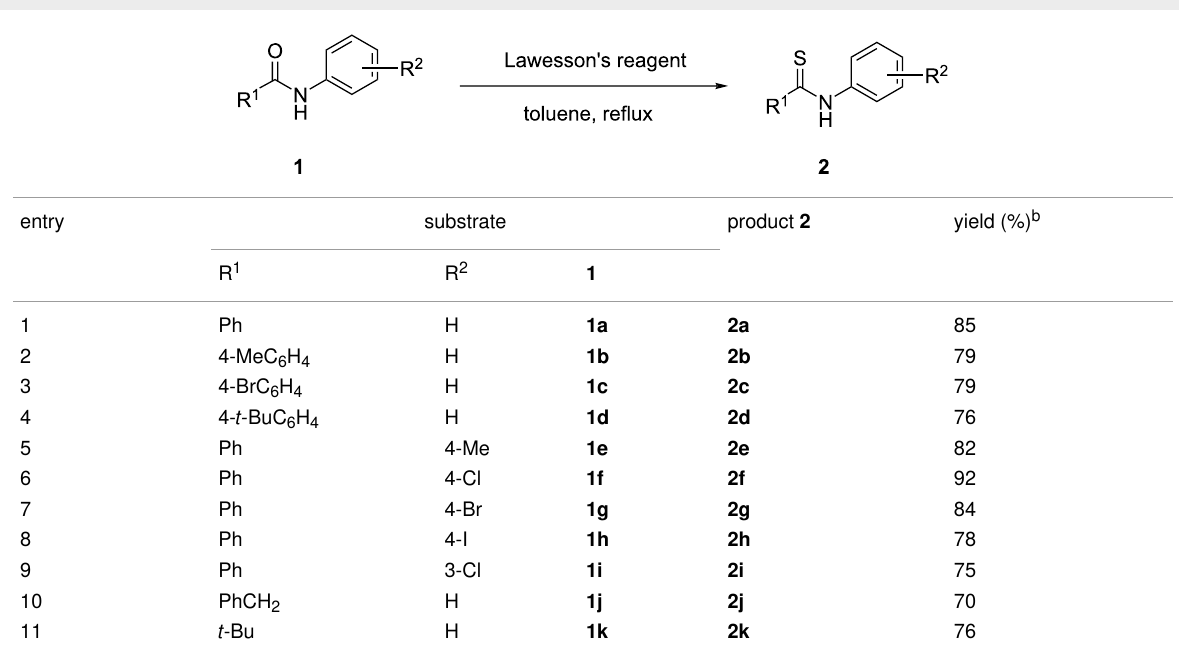
Table 1: Synthesis of thioamides a .